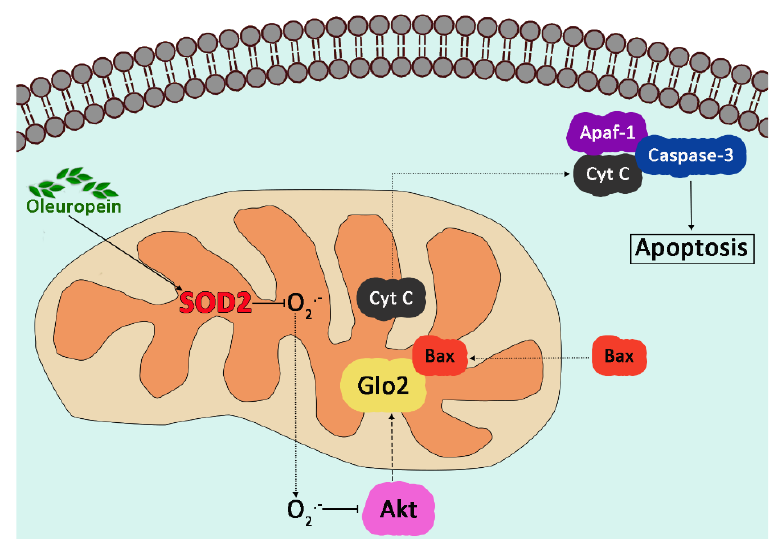
Figure 7. Oleuropein-induced apoptosis through mitochondrial Glo2.